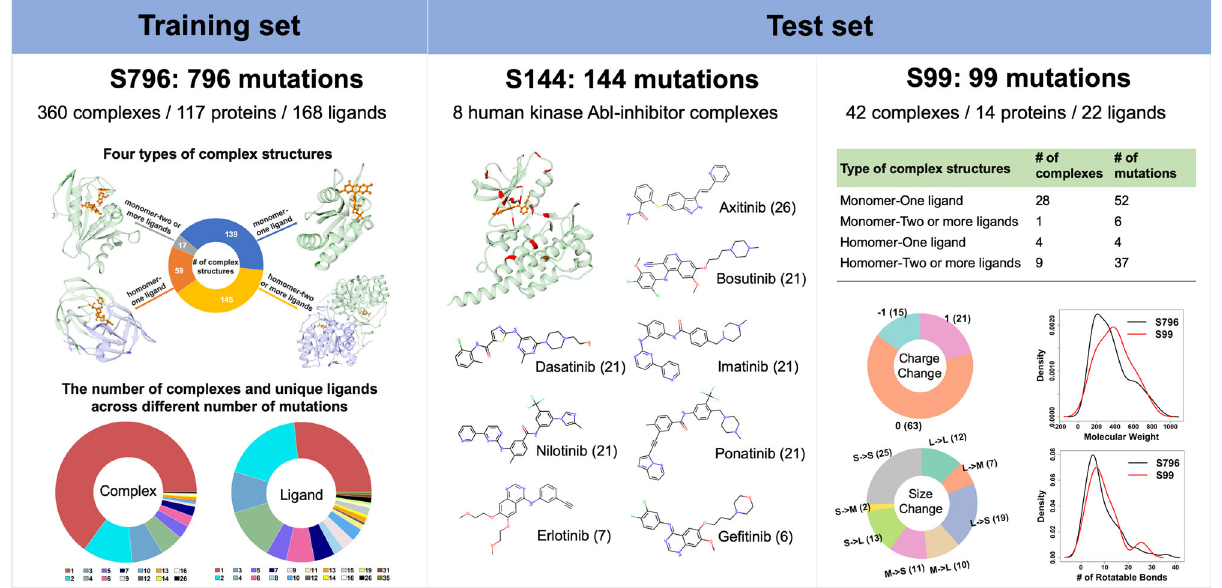
Fig. 2 Overview of the data sets used. S796: visualization of four types of protein – ligand complex structures and distribution of the number of complexes and unique ligands across different number of mutations are presented. Majority of complexes contain only one single mutation; S144: 3D structure of human Abl kinase with axitinib bound (PDB ID: 4WA9, mutation sites are shown in red), names and chemical structures of eight tyrosine kinase inhibitors (TKIs), and the number of mutations for each type of inhibitor are provided; S99: the number of complexes and mutations for each type of complex structure, statistics of the types of mutations (see Supplementary Fig. 1 for the de fi nition), and distribution of molecular weight and number of rotatable bonds for the ligands in S796 and S99 are shown. See Supplementary Figs. 1 and 2 for more information about the data